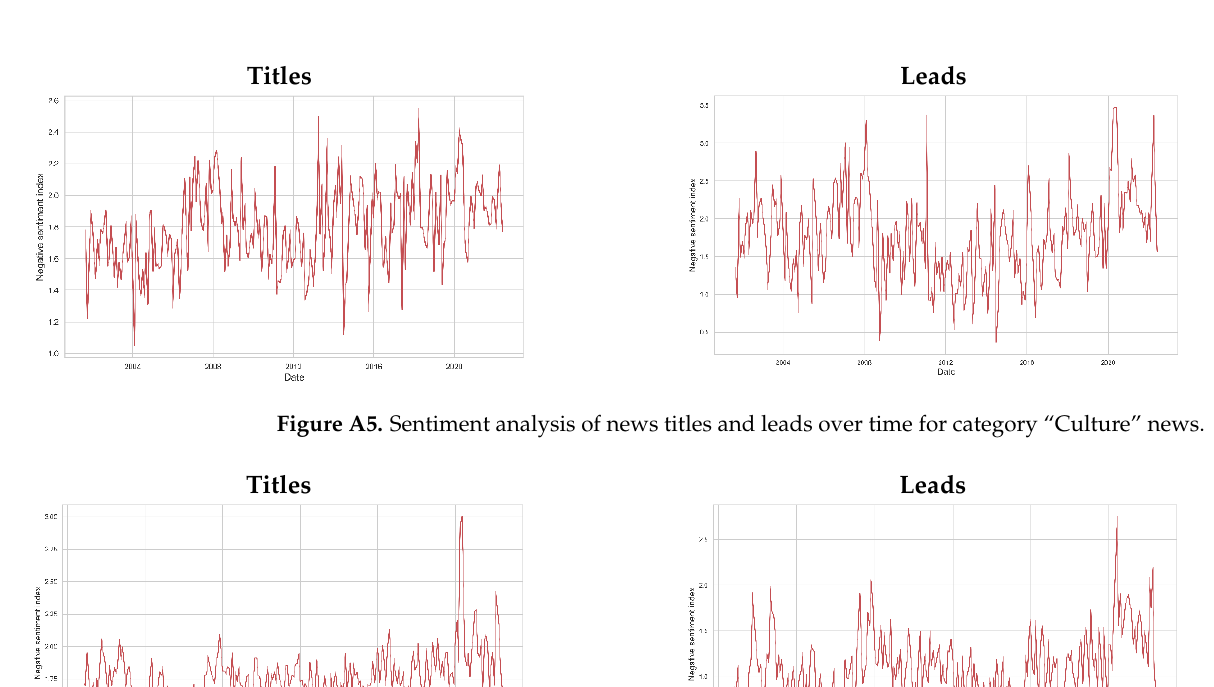
Leads Figure A2. Sentiment analysis of news titles and leads over time for category “ Lithuania ” news. Titles Leads Figure A3. Sentiment analysis of news titles and leads over time for category “ Foreign ” news. Titles Leads